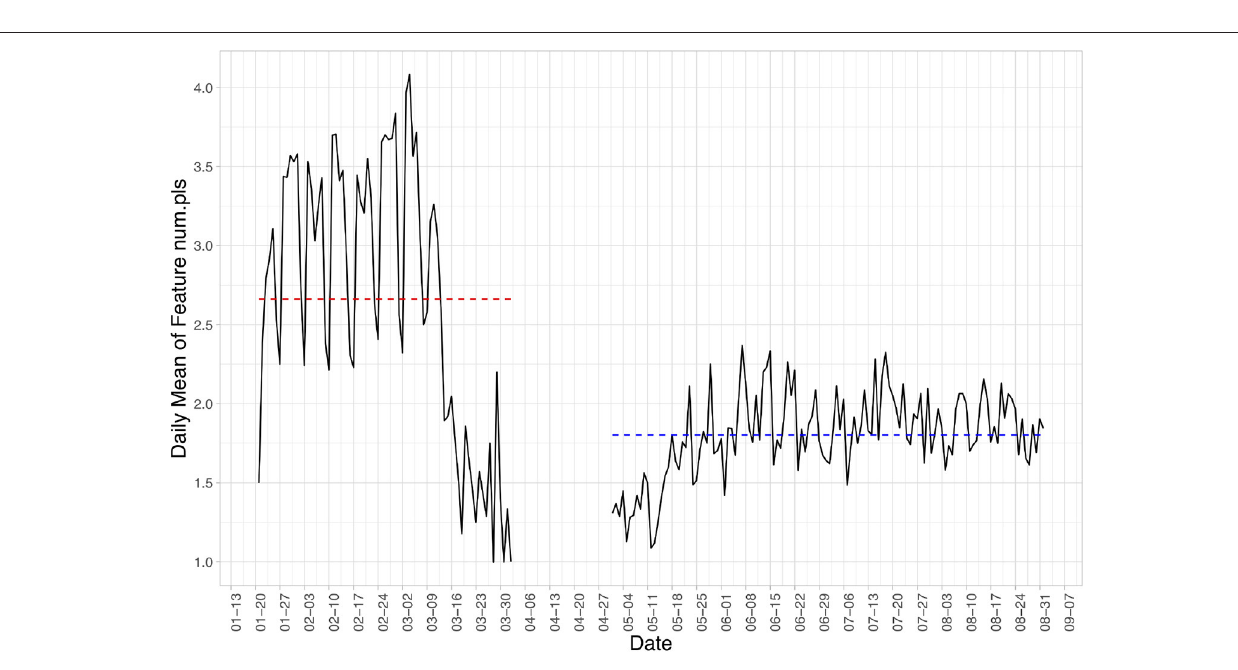
FIGURE 4 | Daily mean value of the num.pls , number of significant places visited, over the two study periods. The red and blue dashed lines indicate the average value from the pre- and post-outbreak group, respectively. Note the drastic drop in March in the pre-outbreak group, coinciding with the declaration of pandemic